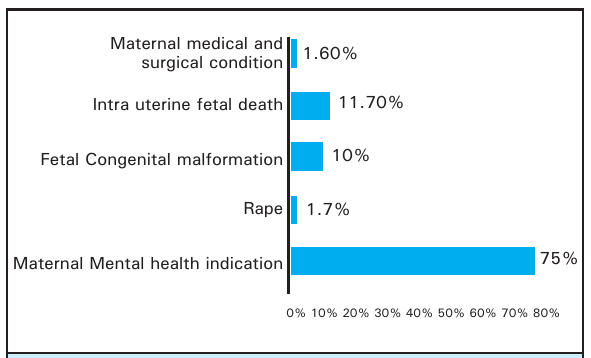
Maternal medical and surgical condition 1.60%